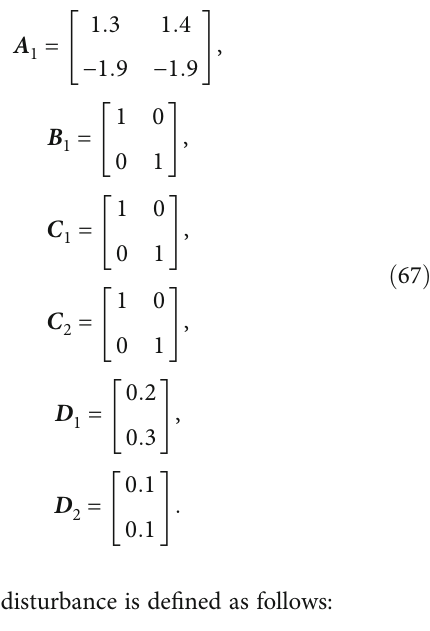
Figure 4. The parameters of switching topologies subject